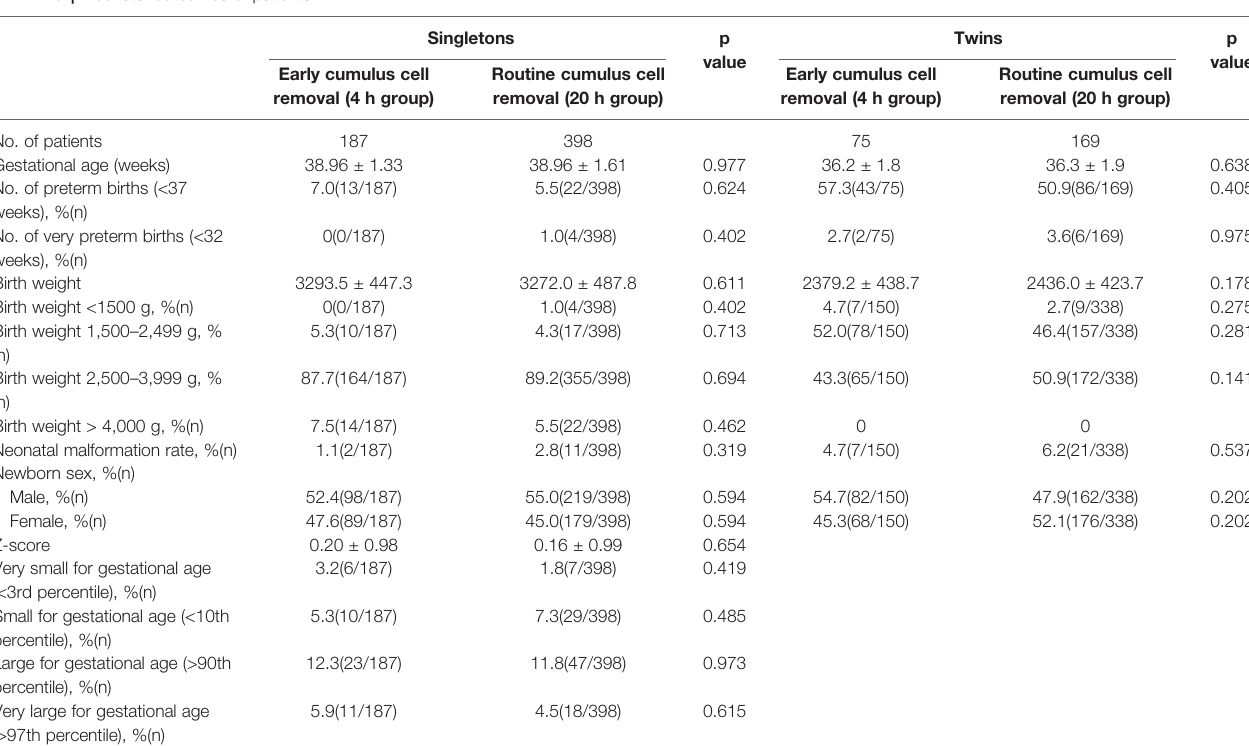
TABLE 3 | Neonatal outcomes of patients.